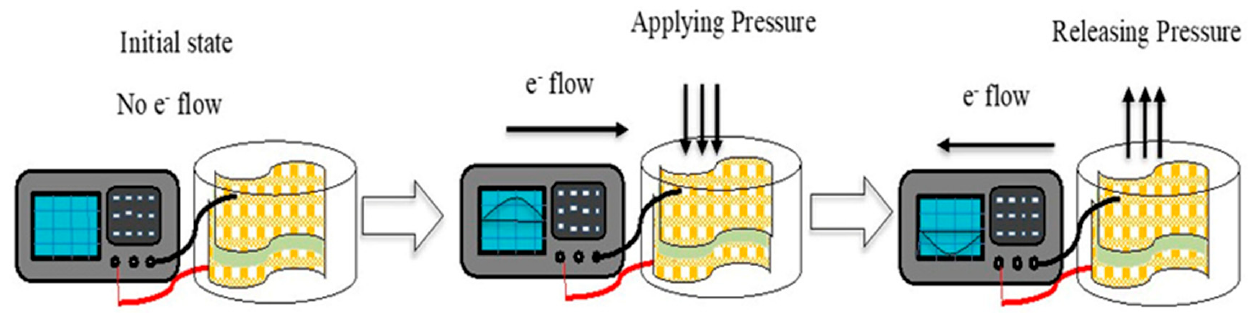
Figure 1. Working principle of a piezoelectric material when applying and releasing pressure. Among the other piezoelectric materials, PVDF has a relatively large piezoelectric and pyroelectric response, which makes it suitable for exploitation in the development of flexible electronic devices [24,26]. PVDF also has an advantage over other materials due to its high mechanical properties, chemical resistance, and good thermal stability, as well as easy fabrication process. Hence, PVDF has been considered the preferred candidate for lightweight piezoelectric sensors with curved surfaces, and for tiny, complex, and flexible structures [6,22,26,27]. For instance, piezoresistive PVDF foils are frequently used as a thin, active electromechanical transducer, which are able to transduce approximately 12% of the mechanical energy to electrical energy, and inversely [21]. A wearable energy harvester generating electric power from heel strikes and strain applied on a backpack strap during walking produced a maximum power of 45.6 mW; as a similar concept, using the knee-joint of a human body, demonstrated by another author, a peak power output of 1.1 mW was achieved, with the PVDF fibres in woven textiles